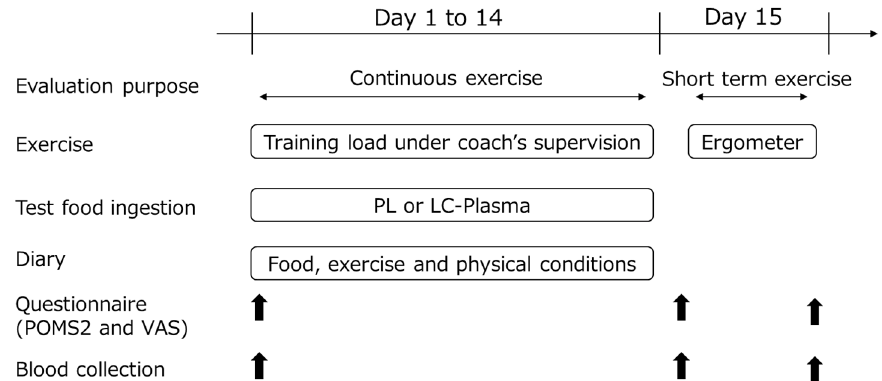
Figure 1. Experimental design. Arrows indicate points when questionnaires and blood collections were taken.